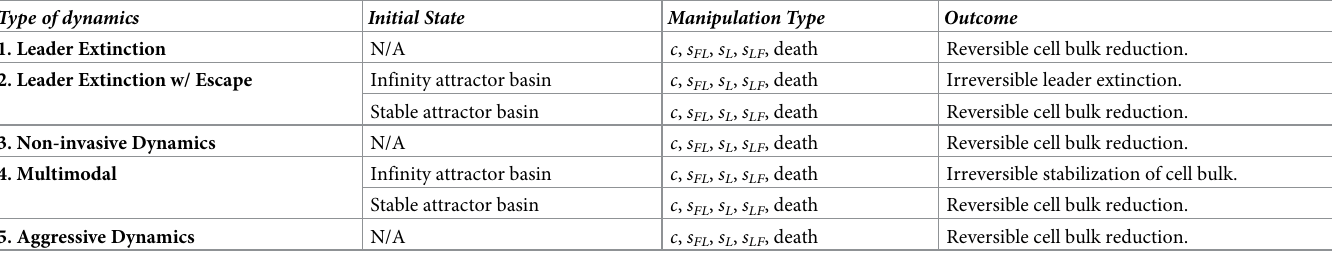
Table 2. Effect of the different feedback alterations on the ecosystem